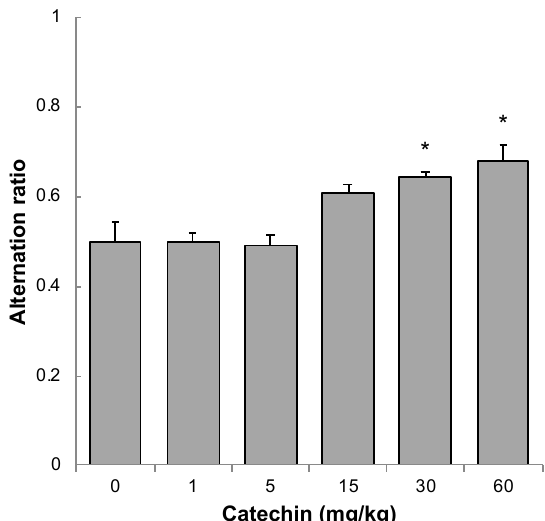
Figure 3. E ff ect of GT-catechin ingestion on working memory of 11-month-old SAMP10 mice. Searching behavior was observed in a Y-maze. The number of occasions in which spontaneous alternation behavior was observed was counted and the ratio of alternation was calculated as follows: (number of arm entries showing spontaneous alternation) / (total number of arm entries − 2) (n = 18–21; * p < 0.05).